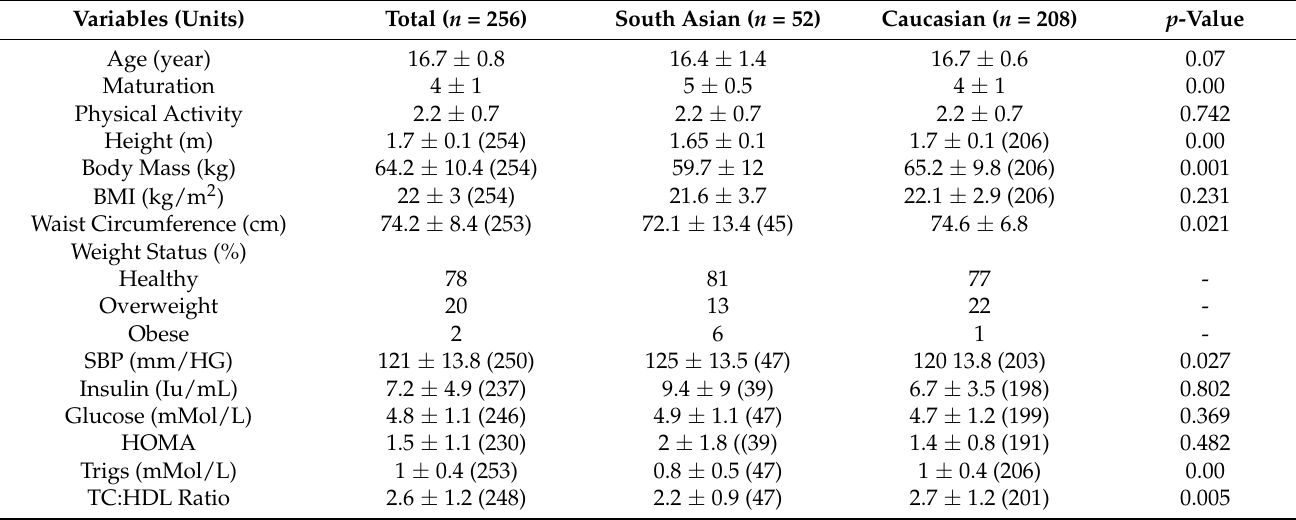
Table 1. Characteristics of the study population.